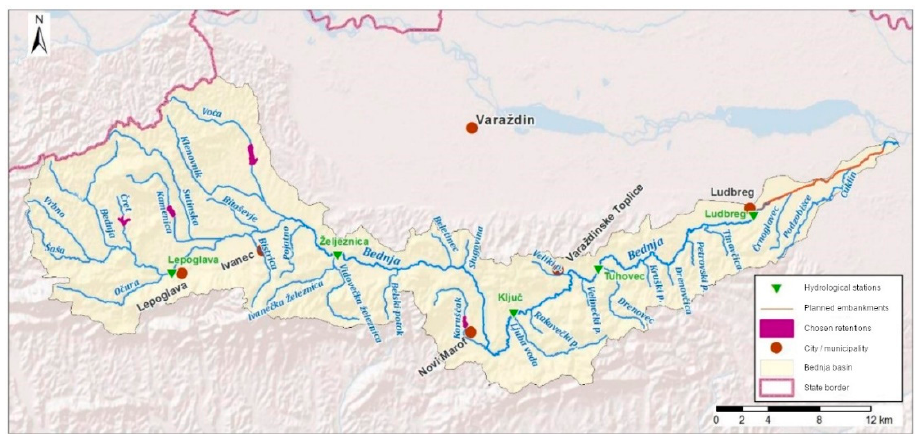
Figure 6. Spatial presentation of hydrological and meteorological stations in the Bednja Basin (from [21]).